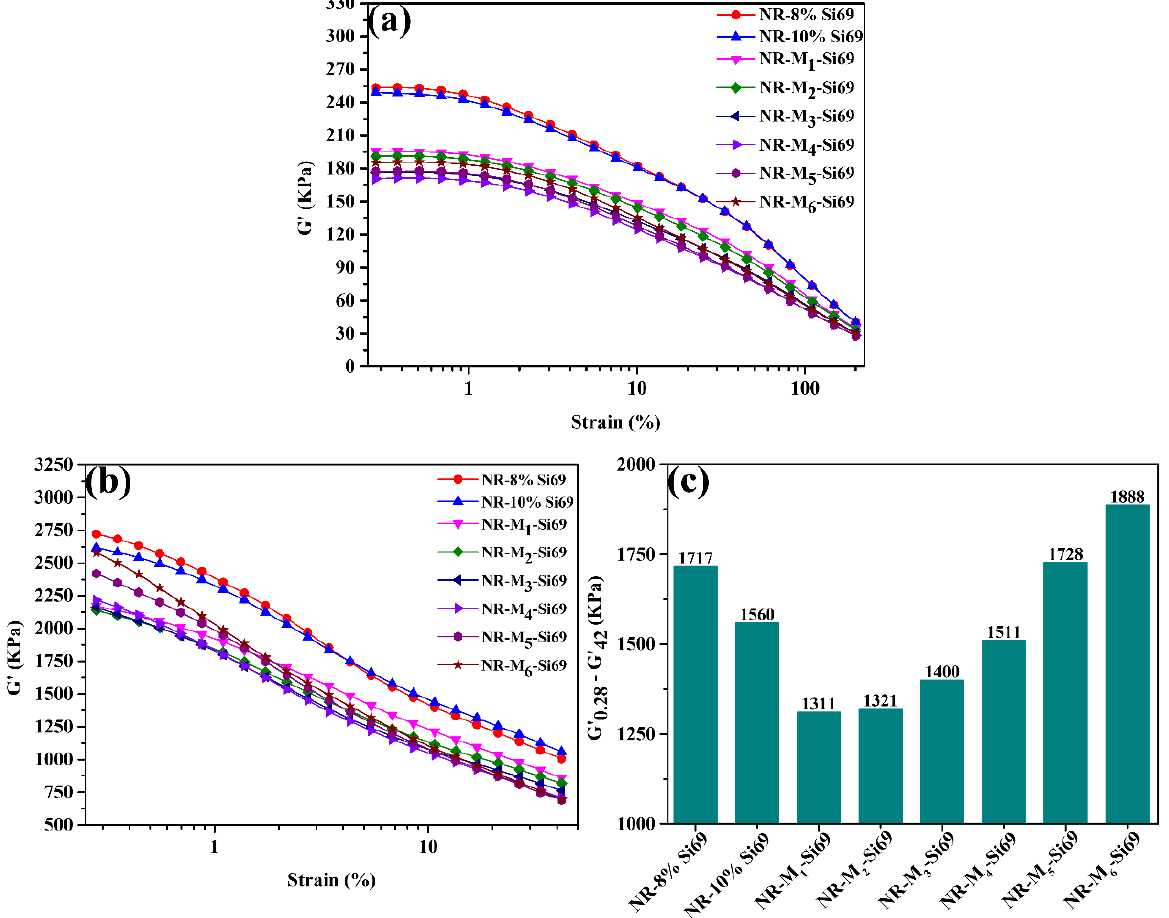
Figure 4. Storage modulus – strain curves of ( a ) unvulcanized silica/NR nanocomposites and ( b ) vulcanized silica/NR nanocomposites; ( c ) difference of storage moduli of vulcanizate silica/NR nanocomposites.